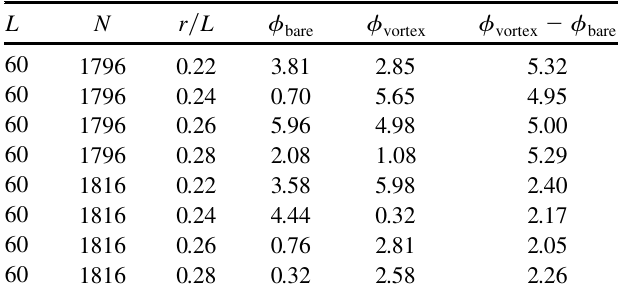
TABLE I. Berry phases for taking one vortex around another. The results are not completely path independent but show reasonable stability.